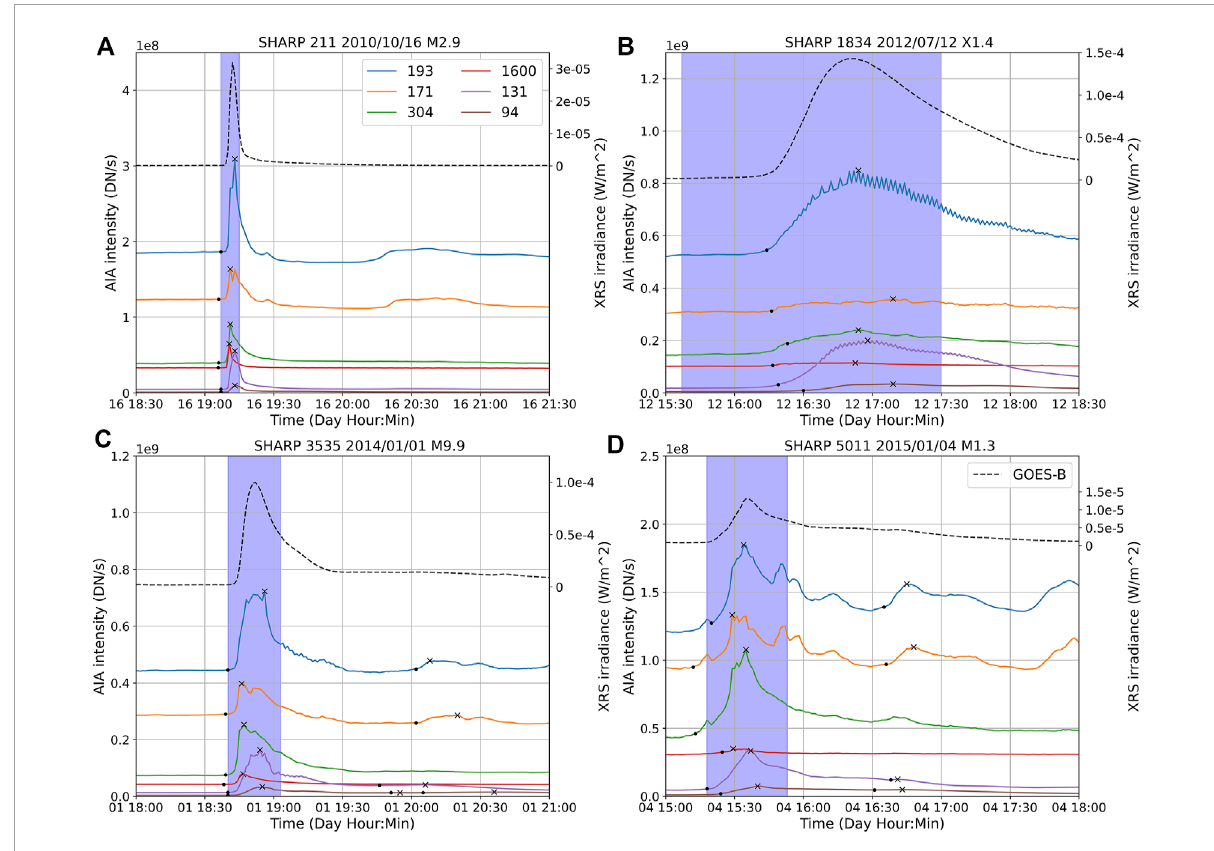
FIGURE 1 Examples of GOES-associated flares as observed in AIA summed-pixel intensity time series for (A) : a M2.9 flare in SHARP 211 on 2010/10/16, (B) : a X1.4 flare in SHARP 1834 on 2012/07/12, (C) : a M9.9 flare in SHARP 3535 on 2014/01/01, and (D) : a M1.3 flare in SHARP 5011 on 2015/01/04. The solid lines show the sum of the AIA pixel intensities over the AIA SHARP image for various wavelengths, the dashed line shows the GOES XRS-B intensity with the right hand y-axis for scale. The blue box depicts the time window of the flare specified in the GOES catalog. The black “x” markers indicate peaks as obtained by our peak finding procedure, and black “.” markers indicate start times. The AIA curves have not been shifted or normalized in these plots. Note that the AIA DN/s scales are different for each plot. The oscillations in the 193 Å and 131 Å curves in panel (B) are due to undercompensation for the AIA auto-exposure